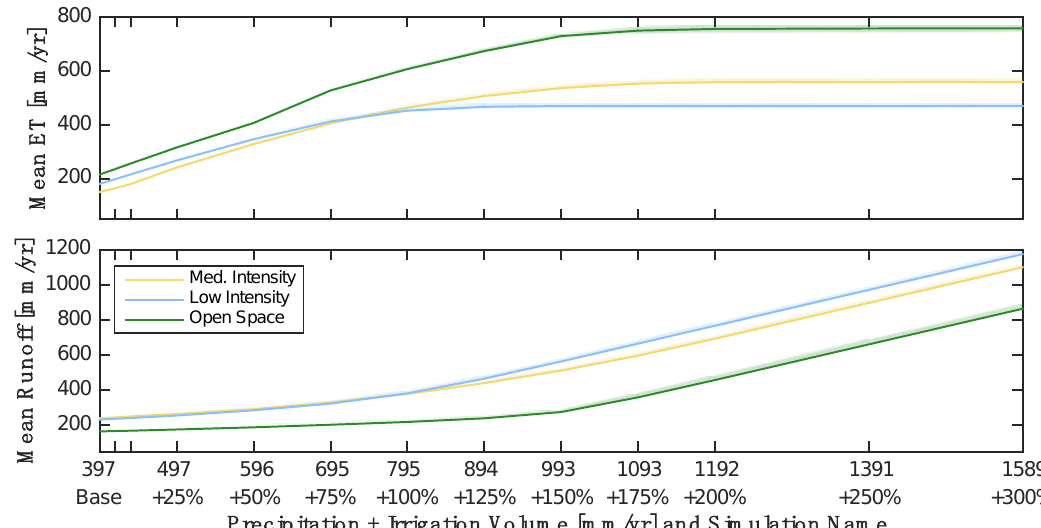
Figure 6. Study-period mean simulated evapotranspiration and runoff. All simulated irrigation timings and volumes for the study period are shown. The shading represents the range of timing, which is small throughout with the largest range seen for the open space LC at +300% simulation.